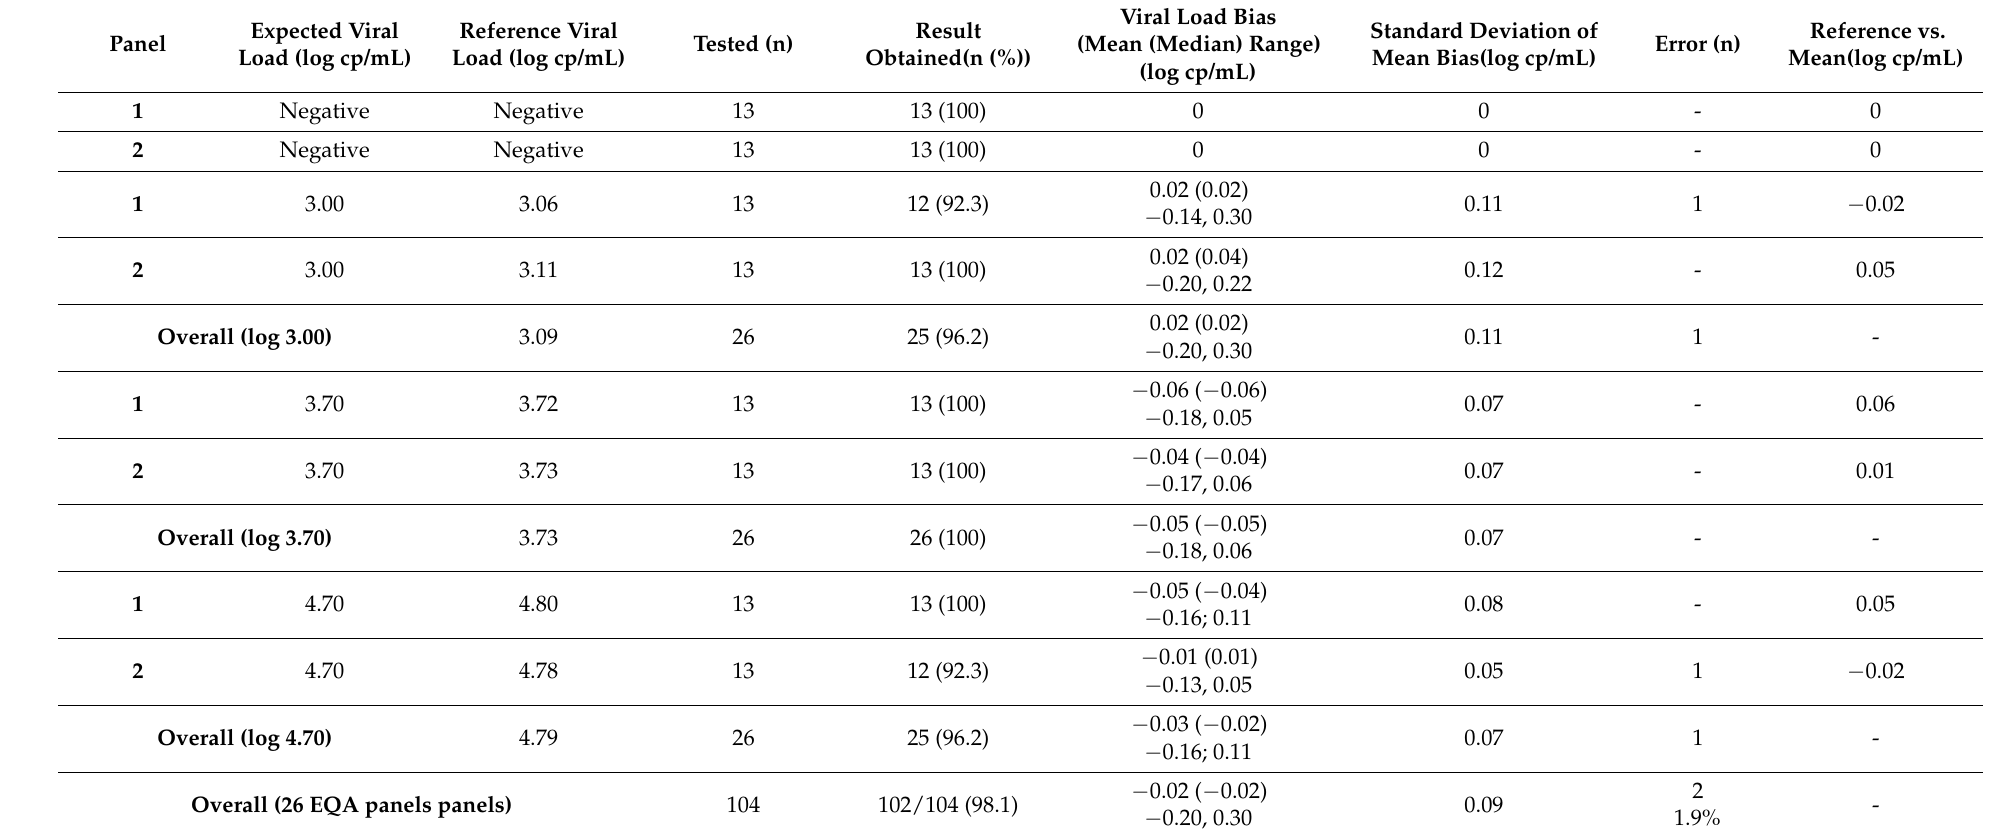
Table 3. Site EQA Summary: September 2017–November